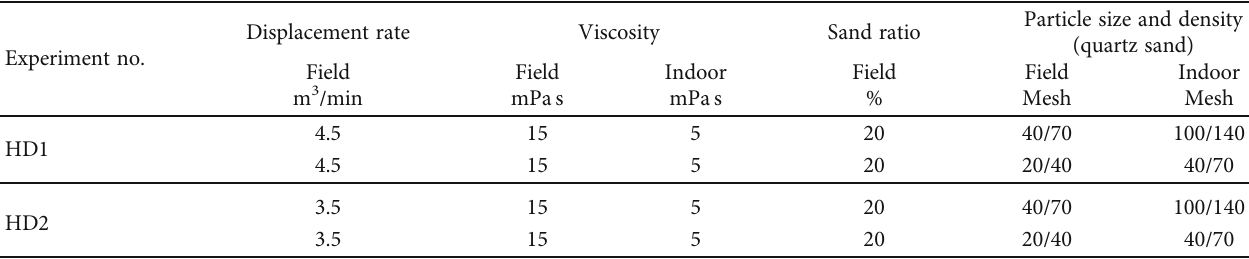
Table 7: Displacement rate exploration experiment scheme of SLG